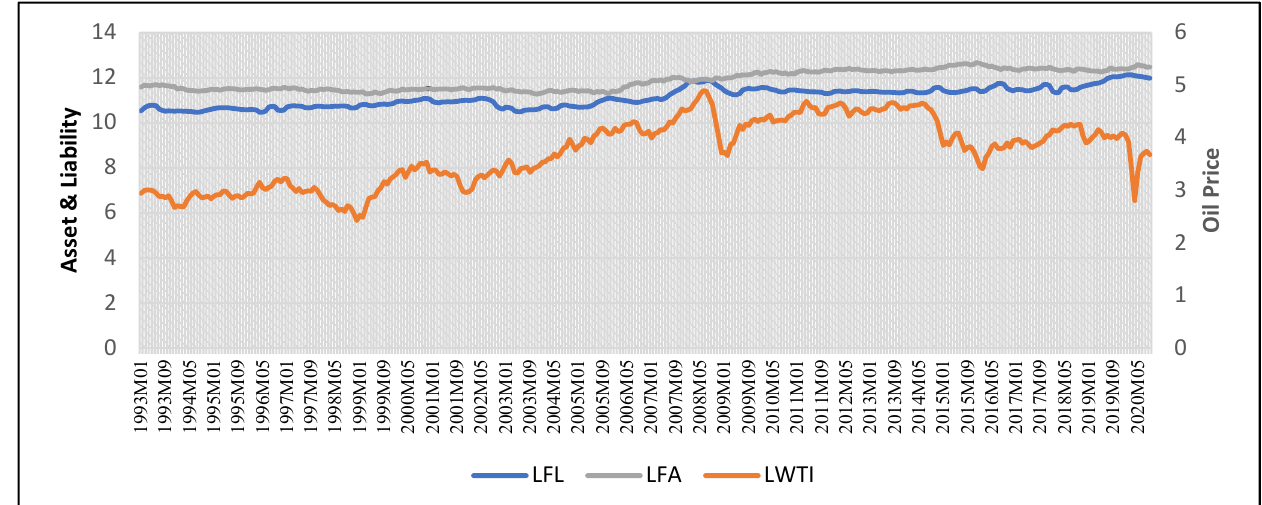
Figure 1. Trend of foreign asset, liability, and oil price.